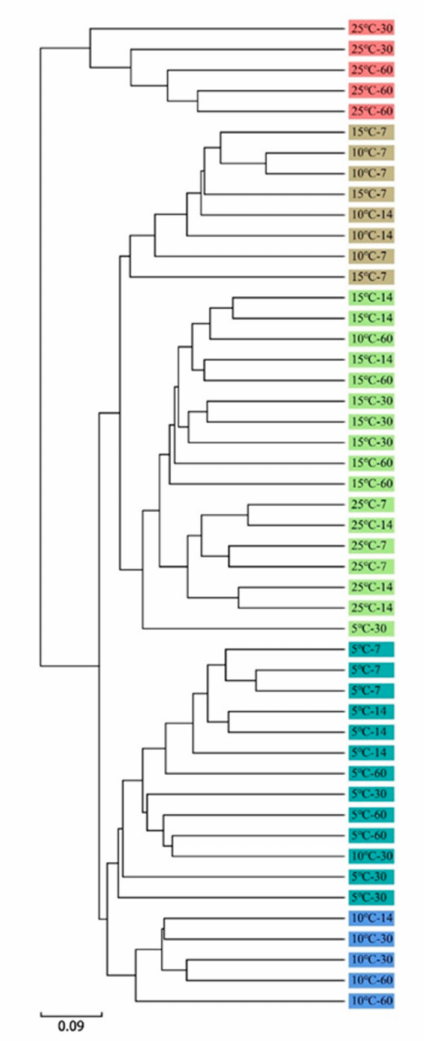
Figure 5. The cluster analysis of microbial community of oat silages based on